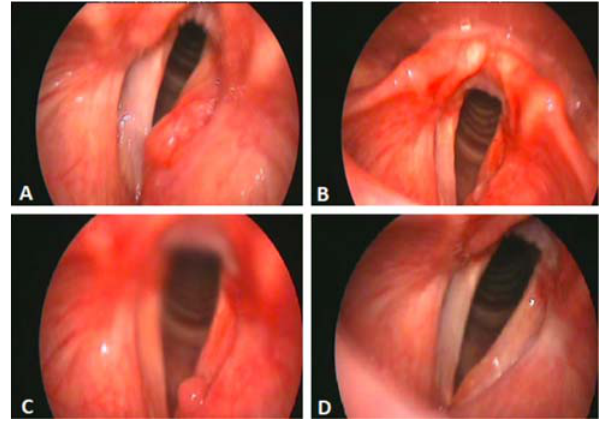
Figure 2: Case 5: endoscopic image before ( A ) and after ( B ) the surgical excision. A small formation in correspondence of the surgical excision at 4 - month laryngeal control ( C ) . Last follow - up examination ( D ) .